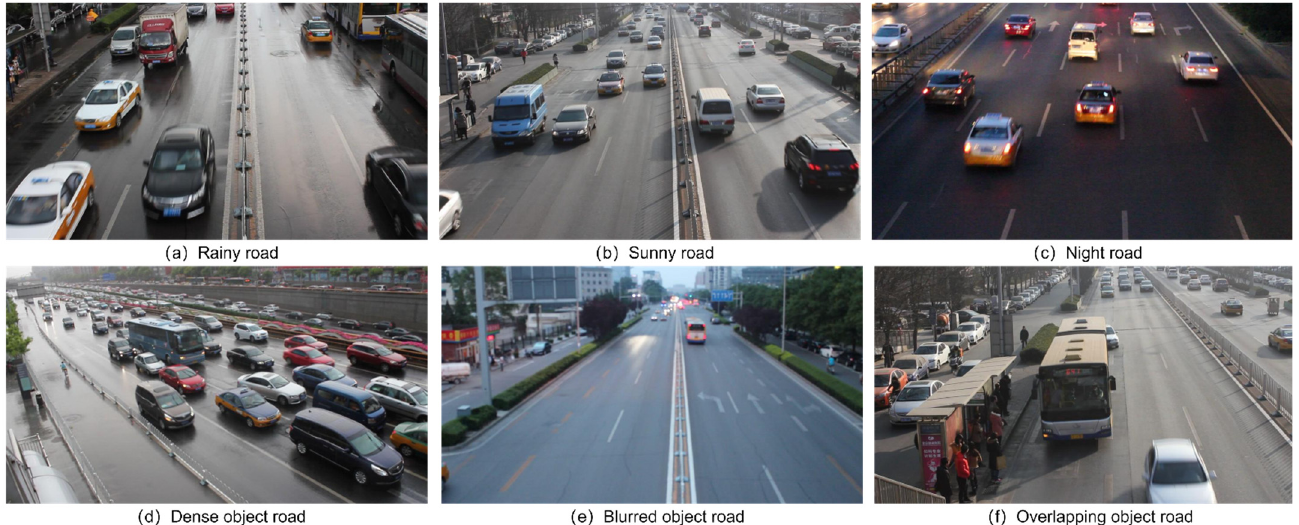
Figure 1. Complex actual roadside images.